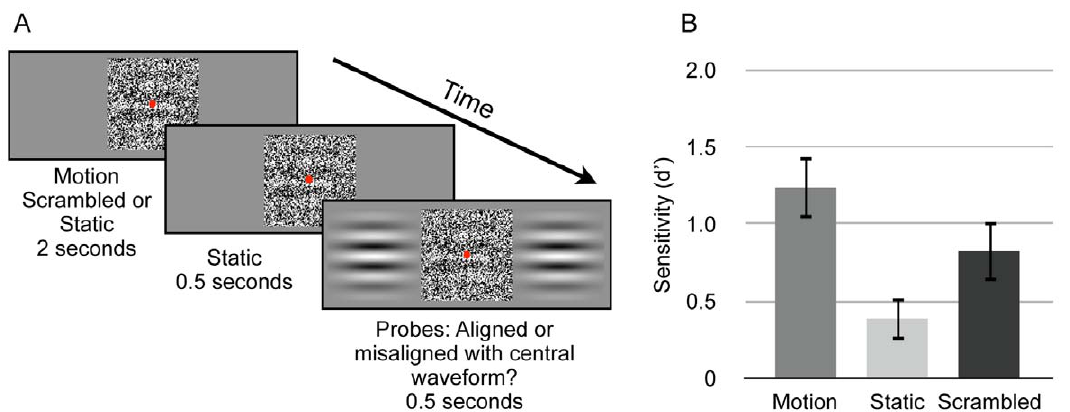
Figure 3. Experiment 2 procedure and alignment sensitivity for static forms. A) Depiction of procedure for Experiment 2. Observers viewed two second presentations of either smooth motion, scrambled motion, or of a static waveform. This was followed by a static inter-stimulus-interval (ISI), after which two adjacent probes were presented that contained waveforms either aligned or misaligned with the central test waveform. Observers were required to complete a forced choice task, indicating if the probe and central waveforms were aligned or misaligned. B) Alignment sensitivities (d 9 ) for 11 observers. Error bars depict + / 2 1 s.e.m.